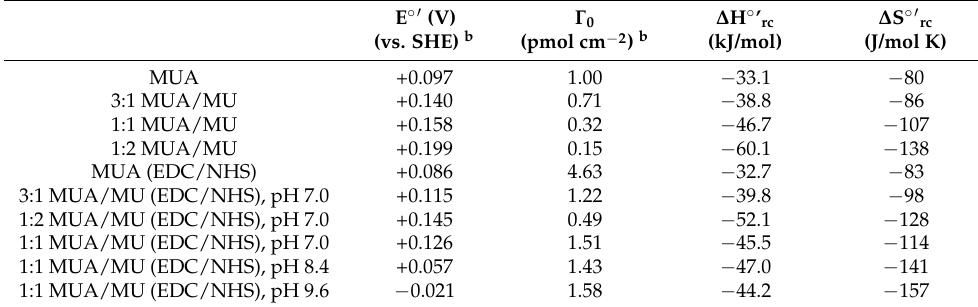
Figure 2. Cyclic voltammograms for wt Streptomyces coelicolor small laccase (SLAC) covalently bound to a SAM of MUA ( A ), 1:1 MUA/MU ( B ), 1:2 MUA/MU ( C ), and 1:3 MUA/MU ( D ) through NHS/EDC chemistry. CVs were recorded in 5 mM Tris-HCl buffer, 5 mM sodium perchlorate, pH 7. Scan rate: 0.05 V s − 1 , T = 20 ◦ C.